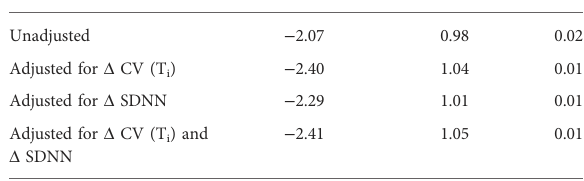
TABLE 4 Ordinal logistic regression for active vs. sham comparison of Δ NRS pain. Covariate